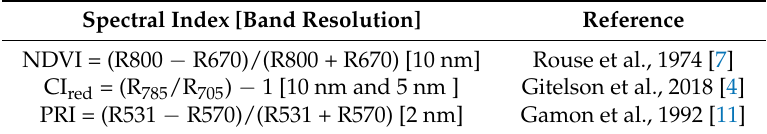
Table 2. Reflectance indices indicative of corn growth, chlorophyll content, and level of